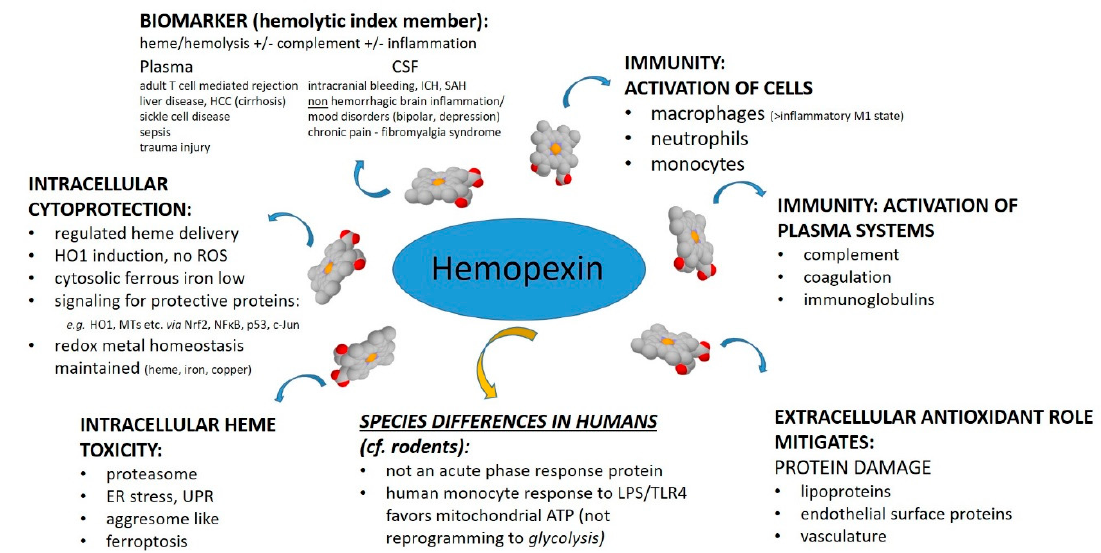
Figure 3. Summary of the current status of the hemopexin (HPX) system and the role it plays in the biological processes that protect the human body against heme- and iron-mediated